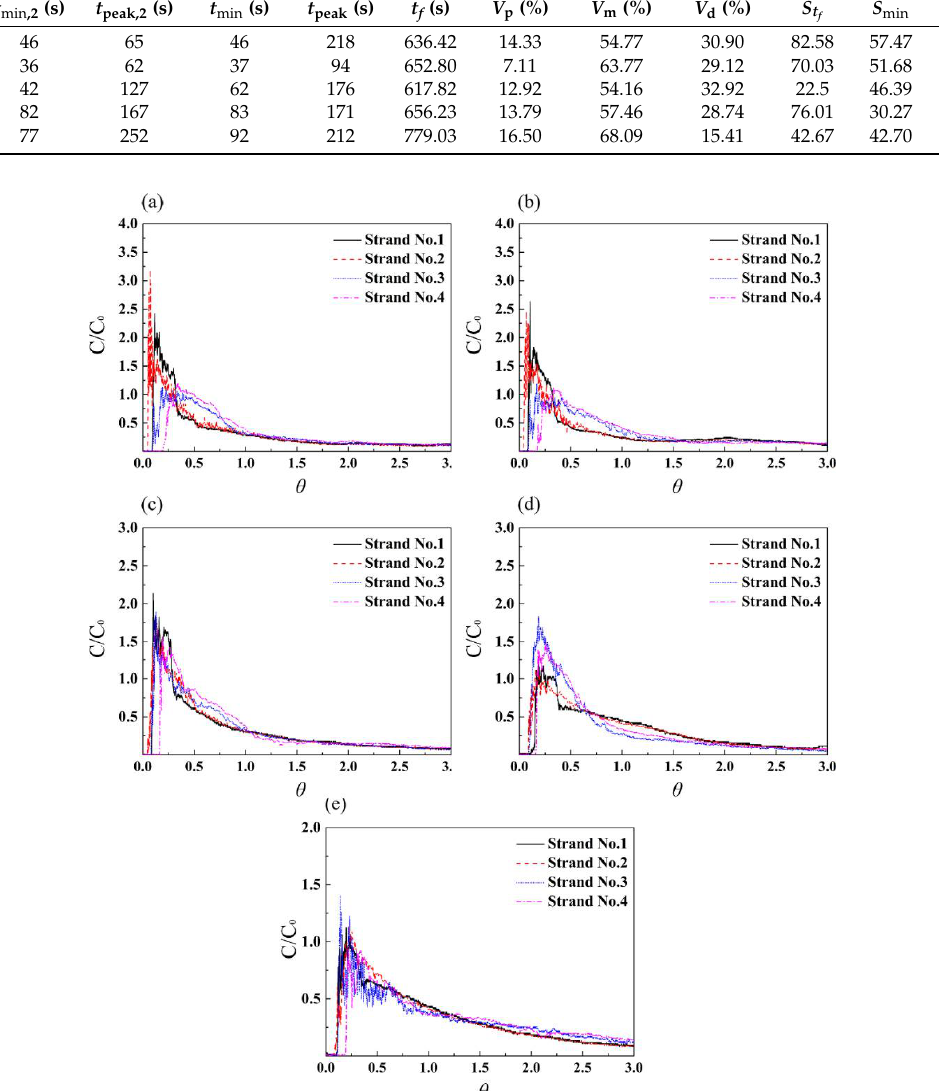
Figure 11. RTD curves of isothermal experiment Part C: ( a – e ) represent cases C1–C5.